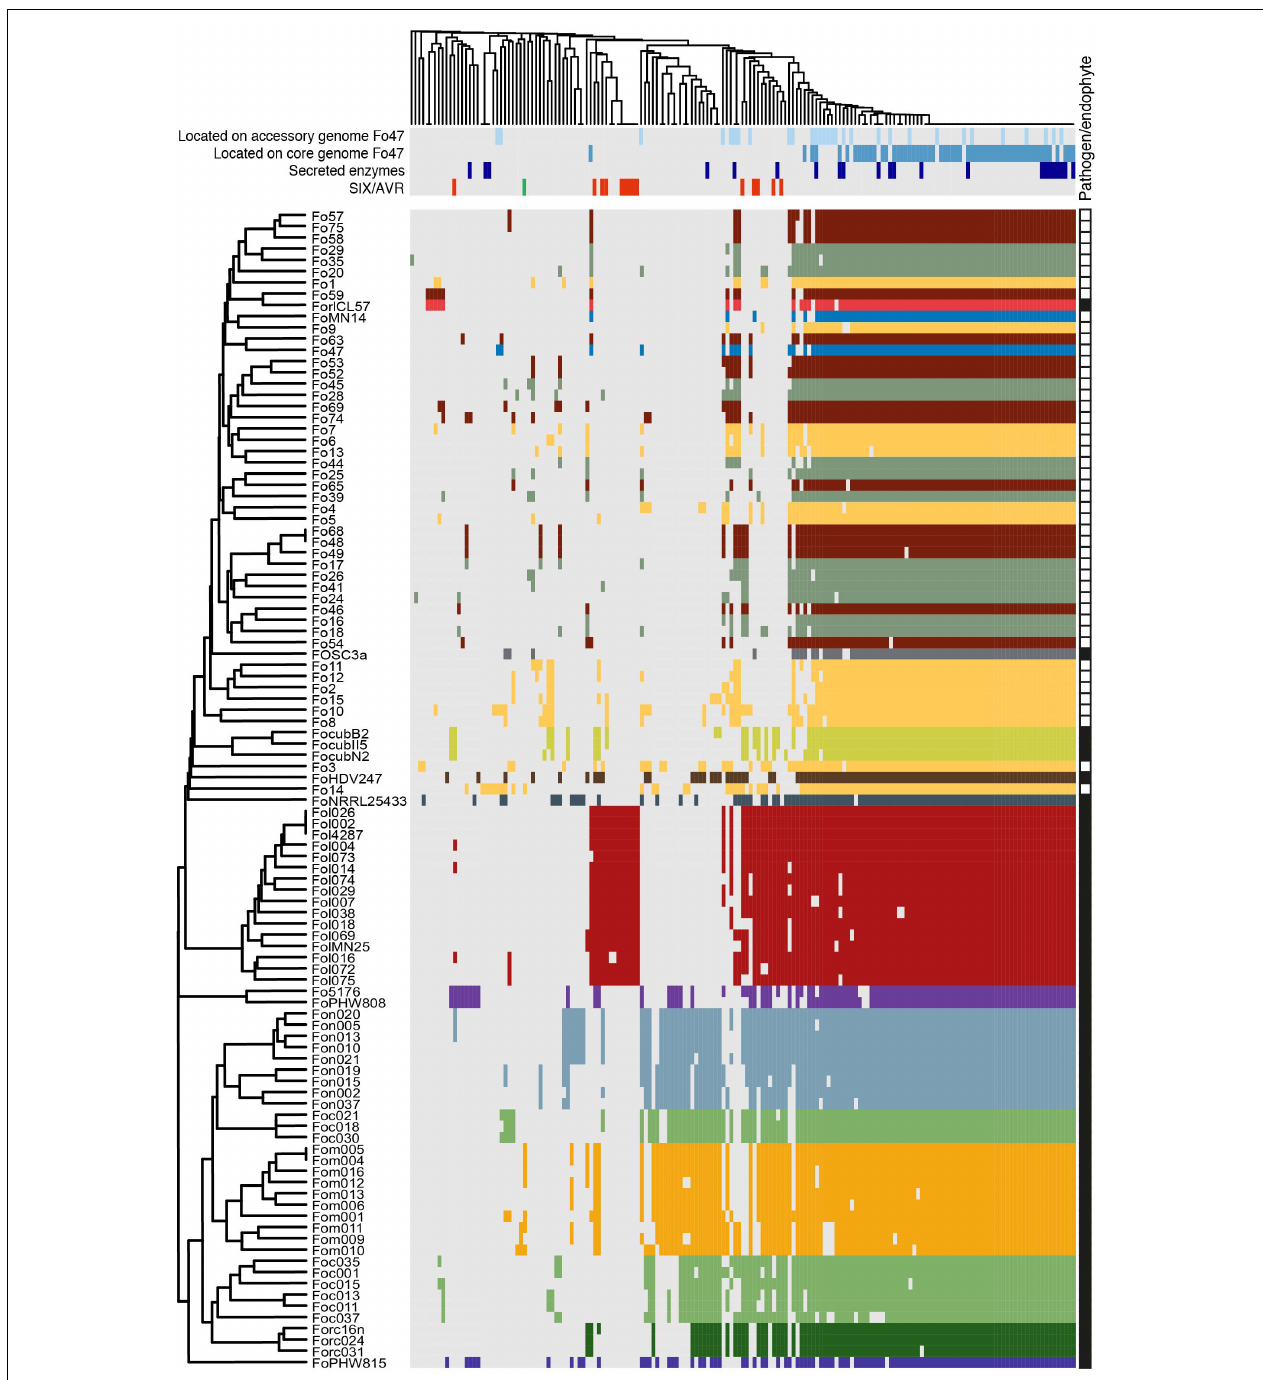
FIGURE 6 | Most endophytic Fo cluster based on presence/absence of 170 candidate effectors genes from 103 genomes. Gray represents absence, while color represents presence of the candidate effector genes. Strains with the same host-preference (pathogens) or from the same habitat (endophytes) have the same color. For the endophytes we followed the same color scheme as in Figure 1 : yellow – Australia; green – Spain; maroon – United States, blue – France (Fo47). FoMN14 was not sequenced for this study, but is an endophyte isolated from tomato plants in the United States and therefore colored maroon. Whether strains were considered ‘pathogen’ or ‘endophyte’ is indicated with black and white squares, respectively, in the rightmost column. On top, light blue: candidate effector genes which are located on the accessory genome of Fo47; dark blue: candidate effector genes which are located on the core genome of Fo47; dark purple: putative secreted enzymes; red: SIX genes, green: AVRFOM2 . The newly identified putative effectors are summarized in detail in Supplementary Table 5 .